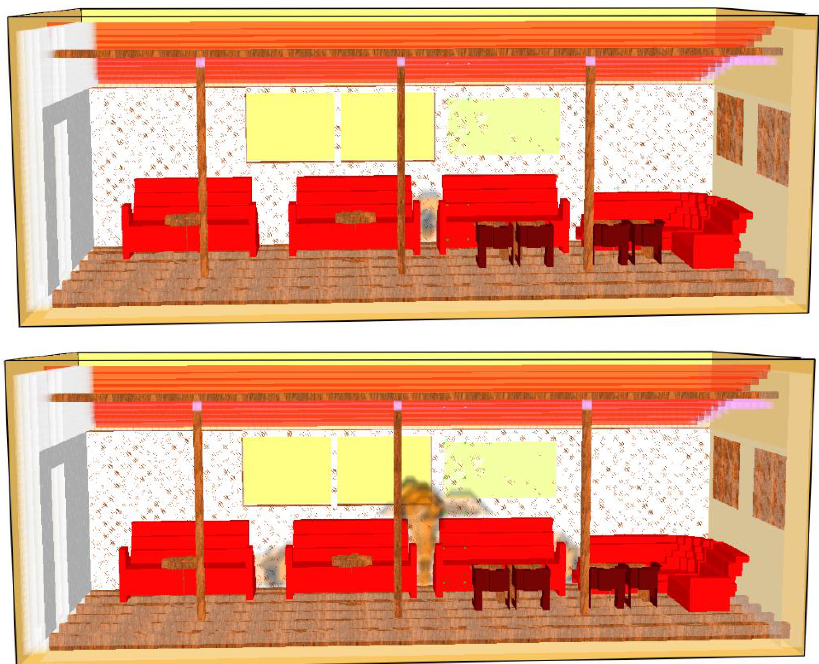
Figure 6. The fire ignites the floor’s wooden support beam and spreads into the first level of the restaurant lounge.